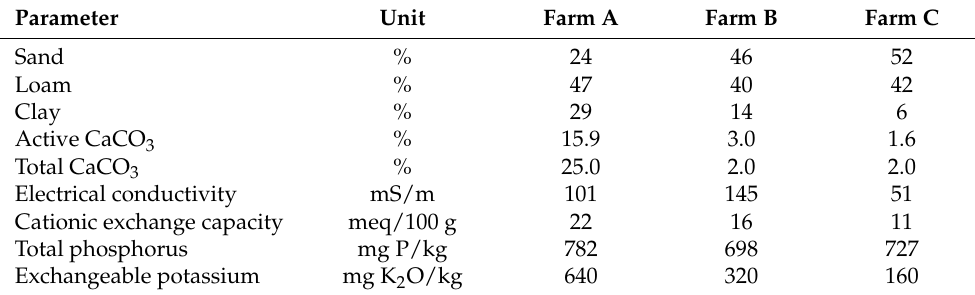
Table 1. Main characteristics of the three farm soils at a depth of